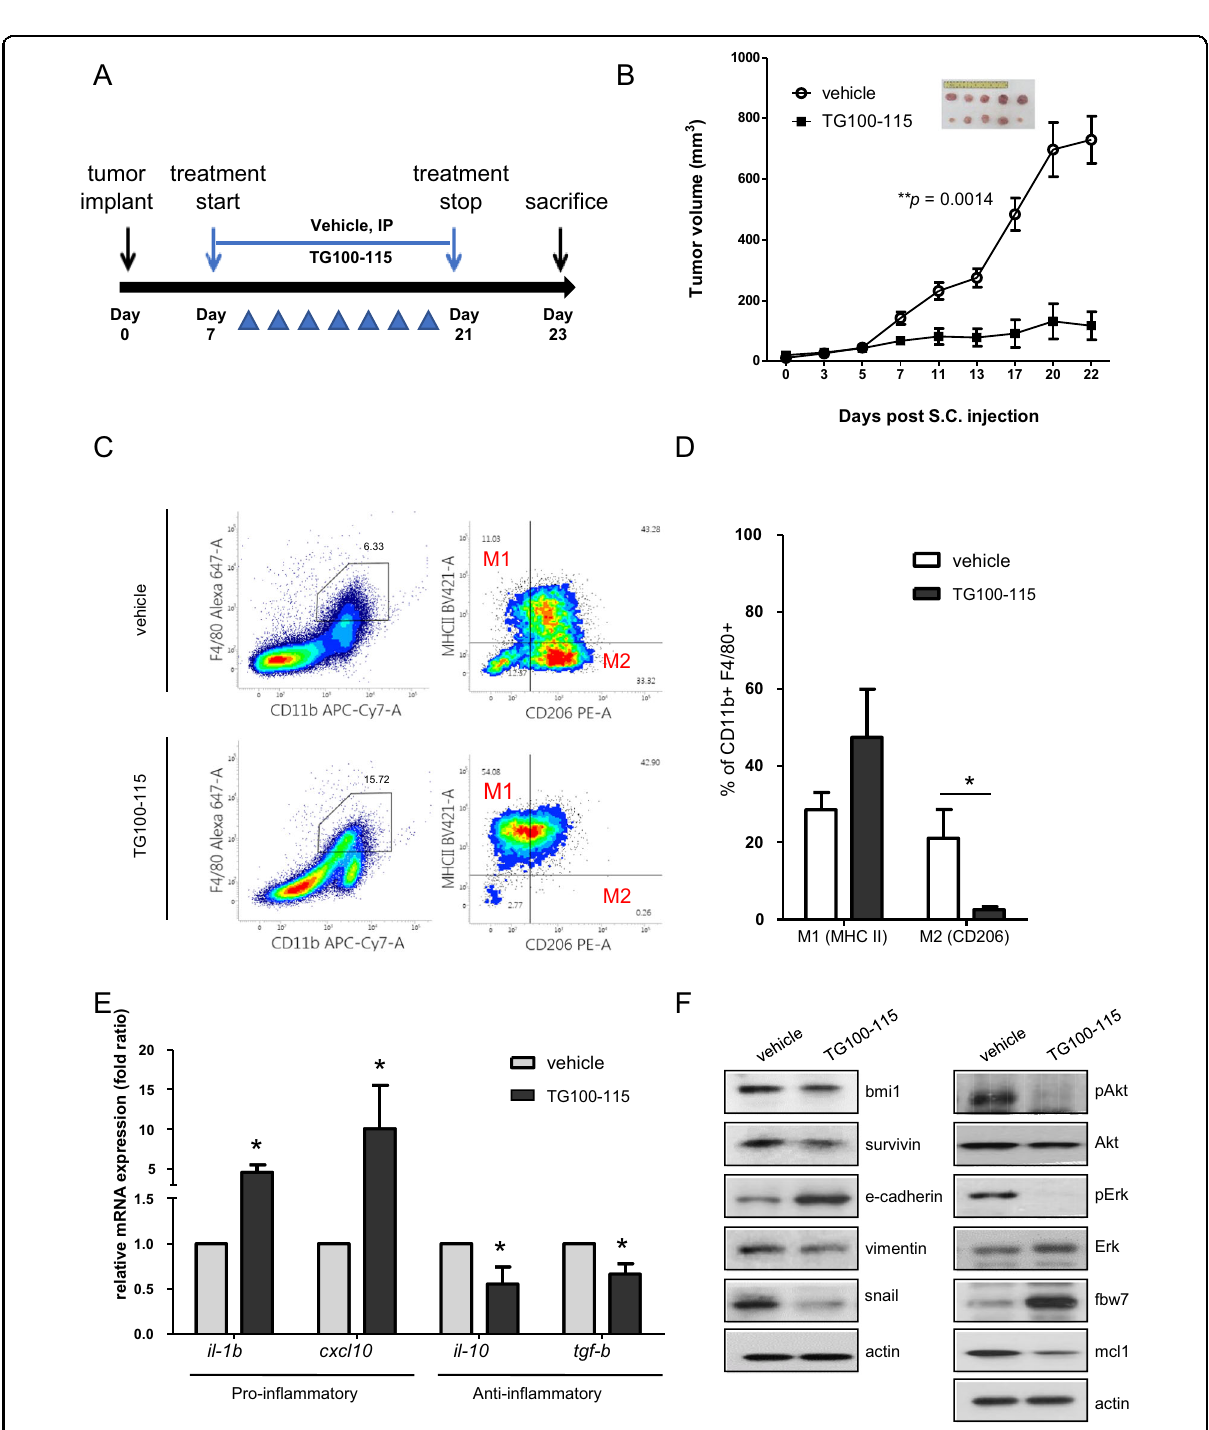
Fig. 7 Inhibition of PI3K γ attenuates tumor growth in xenograft models associated with in fi ltrated macrophages. a Experimental procedure illustrating the TG100-115 treatment regimen in BALB/c mice. b CT26 cells (5 × 10 5 cells/mouse) were subcutaneously injected into the fl anks of 6- week-old mice. Mean tumor volume of subcutaneously implanted vehicle- or TG100-115-treated mice ( n = 5) and representative images of subcutaneous tumors at day 16 after treatment with vehicle or TG100-115 (box) are shown. c FACS analysis and quanti fi cation of CD11b + F4/80 + (TAM) cell populations in CT26 tumors at day 14 posttreatment ( n = 5) and expression levels of MHCII (M1) and CD206 (M2) in CD11b + F4/80 + cell populations. d Graph showing the percentage of each population (M1, M2) in the vehicle-treated group in comparison with the TG100-115-treated group. e mRNA expression levels of genes involved in the proin fl ammatory response ( il-1 β , cxcl10 ) and antiin fl ammatory response ( il-10 and tgf- β ) were evaluated by real-time PCR in vehicle and TG100-155-treated groups. f Representative western blot analysis showing survival/EMT-related protein expression as well as ERK/AKT-FBW7-MCL-1 signal axis regulation in vehicle- and TG100-155-treated mouse tumor